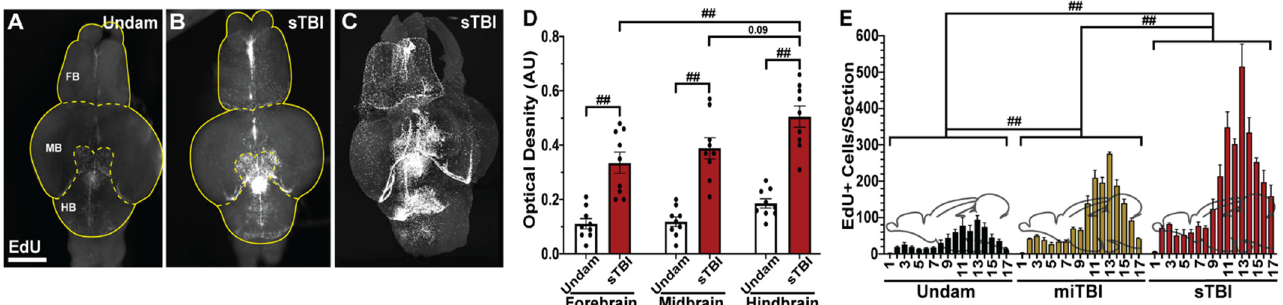
Figure 8. Blunt-force TBI results in increased proliferation in the brain. ( A , B ) Dorsal view of isolated and chemically-cleared undamaged ( A ) and sTBI ( B ) brains labeled with EdU and analyzed by fluorescent microscopy. The position of the forebrain (FB), midbrain (MB), and hindbrain (HB) are delineated. ( C ) Chemically-cleared sTBI brain imaged by lightsheet microscopy. ( D ) Quantification of optical density of EdU fluorescence by bulk brain region revealed significant increases in fluorescence in all sTBI regions relative to undamaged brains, with the largest increase seen in the hindbrain near the impact epicenter (n = 9). ( E ) Quantification of the total number of EdU-positive cells per section across the neuroaxis of undamaged, miTBI, and sTBI fish (n = 4). Significant increases in proliferation were observed in miTBI and sTBI brains relative to undamaged brains from the rostral tip of the olfactory bulb to caudal tip of the cerebellum. Scale bar = 500 µm. Mean ± SEM is depicted in D and E. Statistical analyses were performed with either a One-way ANOVA or Two-way ANOVA followed by a Tukey post-hoc test. ## p < 0.01.